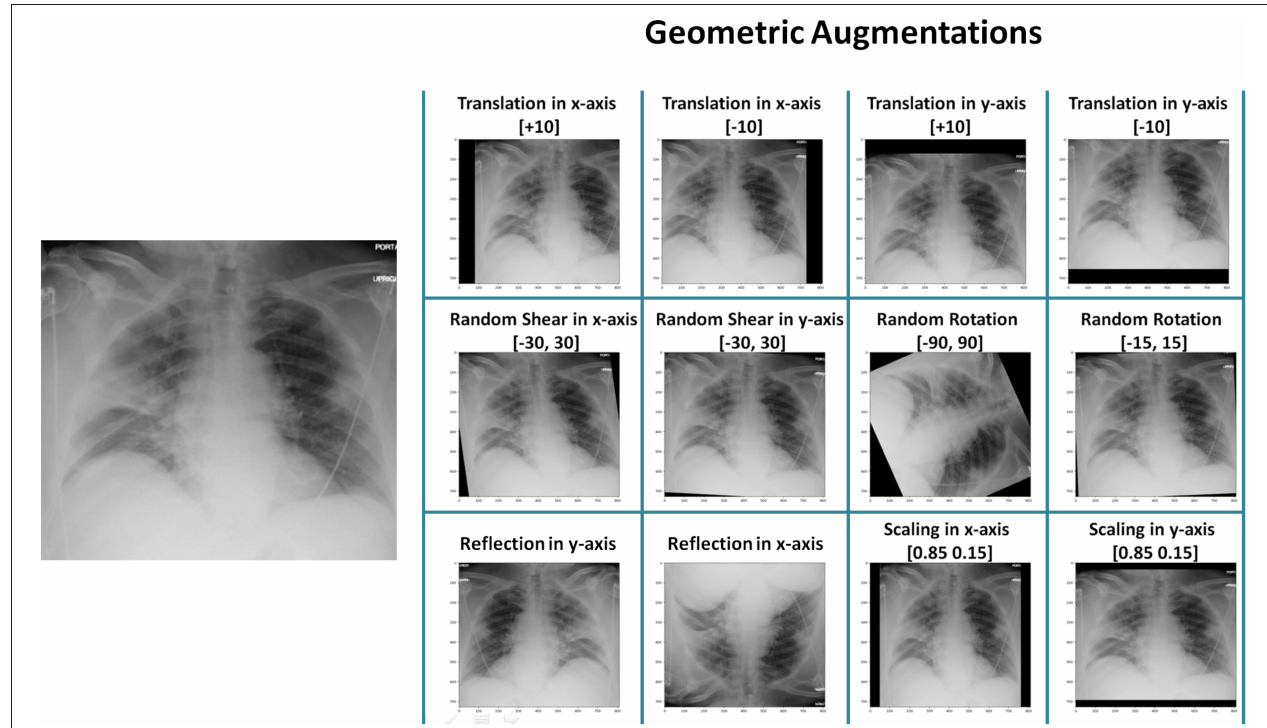
FIGURE 1 | Application of different geometric augmentation transformations to a COVID-19 X-ray image.